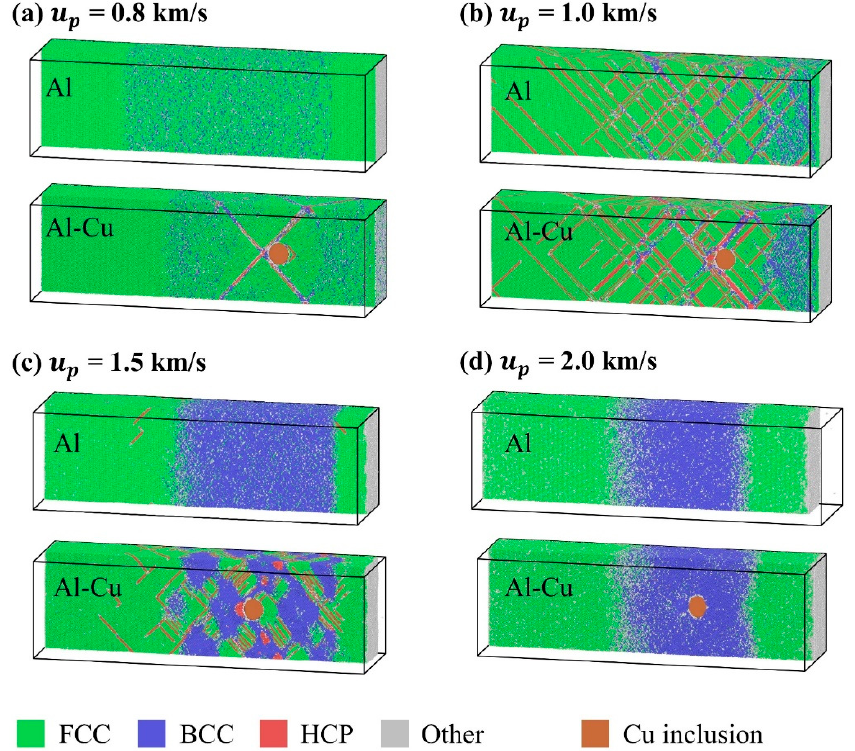
Figure 4. Atomic configurations during shock compression at 18 ps for different piston velocities as indicated in each figure. Al atom are color coded by adaptive common neighbor analysis (a-CNA). The cut surfaces of Cu inclusions are colored by the color of metallic copper. ( a ) u p = 0.8 km/s; ( b ) u p = 1.0 km/s; ( c ) u p = 1.5 km/s; ( d ) u p = 2.0 km/s.